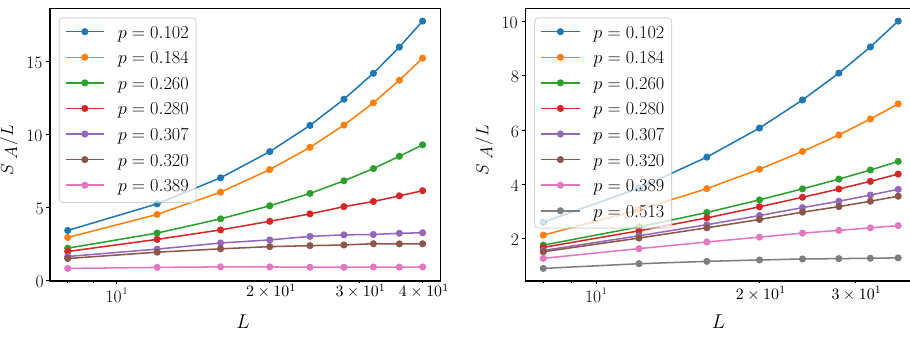
FIG. 12. Left: long-time entanglement entropy S A of a subregion of size L / 2 × L averaged over O ( 10 3 ) random realizations of the unitary circuit defined in Eq. (7). Right: long-time entanglement entropy of a subregion of size L / 2 × L averaged over O ( 10 4 ) random realizations of the rotated nonunitary circuit [Eq. (8)]. The critical point is at p c ≈ 0.28 for both